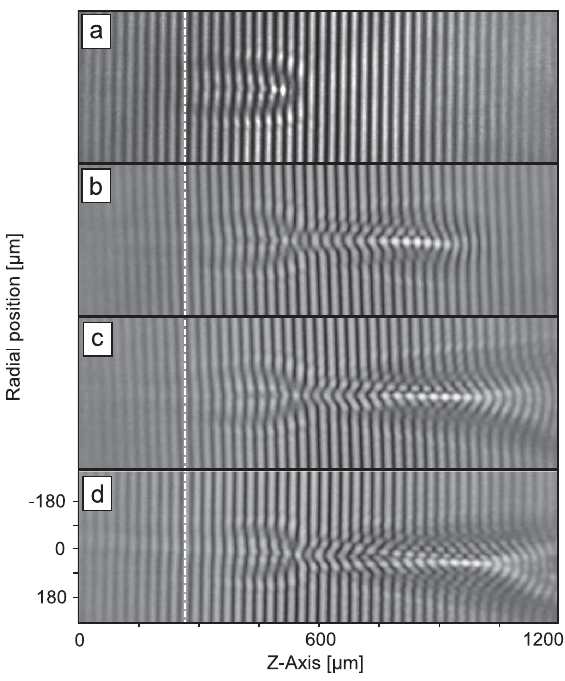
FIG. 3. Interferograms of the plasma channel at the laser power P ¼ 0 : 3 TW (the pulse energy 90 mJ and pulse duration 0.3 ps) and 1 : 5 (cid:3) 10 19 cm (cid:4) 3 gas density at different times. Parts (a)–(d) show the interferograms at different time delays: (a) 1 ps, (b) 3 ps, (c) 5 ps, (d) 9 ps.